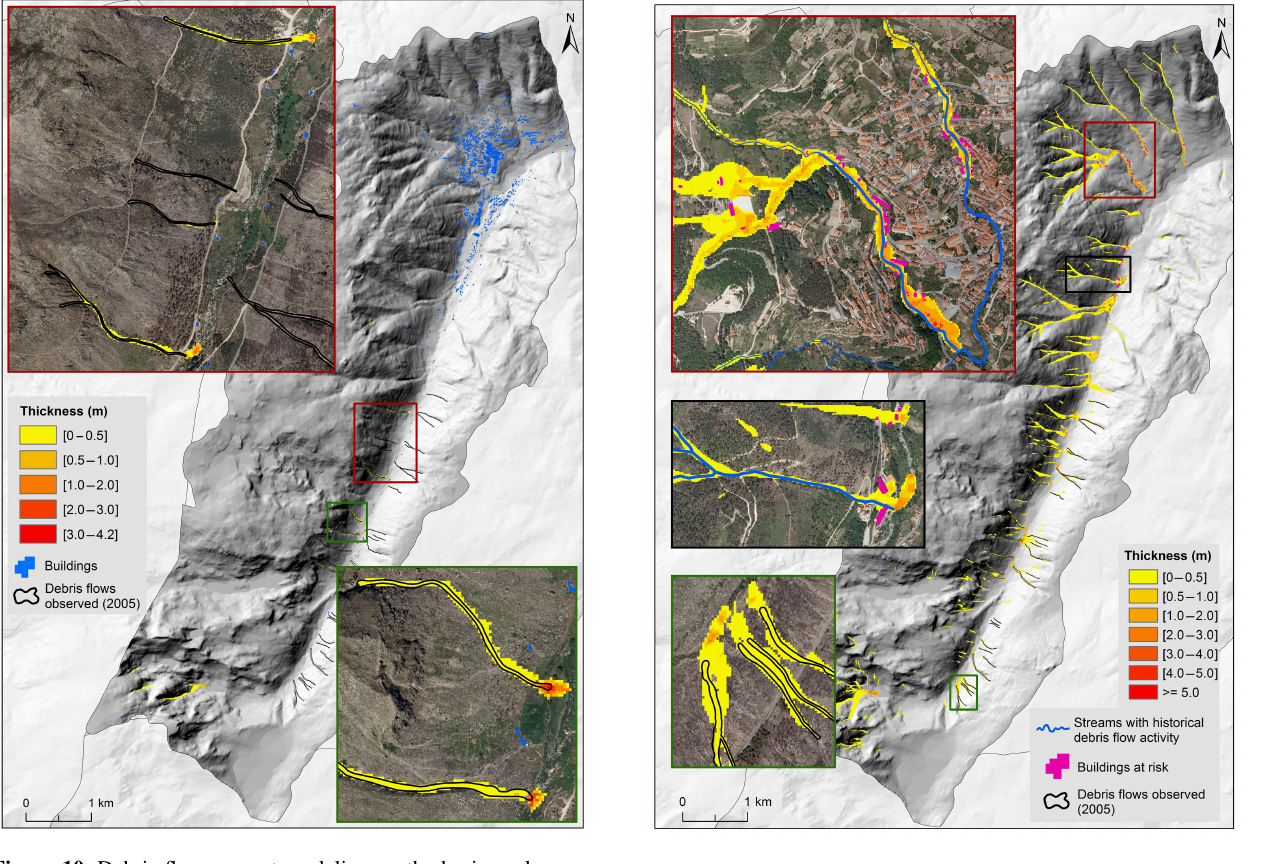
Figure 11. Debris flow run-out modeling on the basin scale, con- sidering excess rain of 35mmh − 1 (Scenario